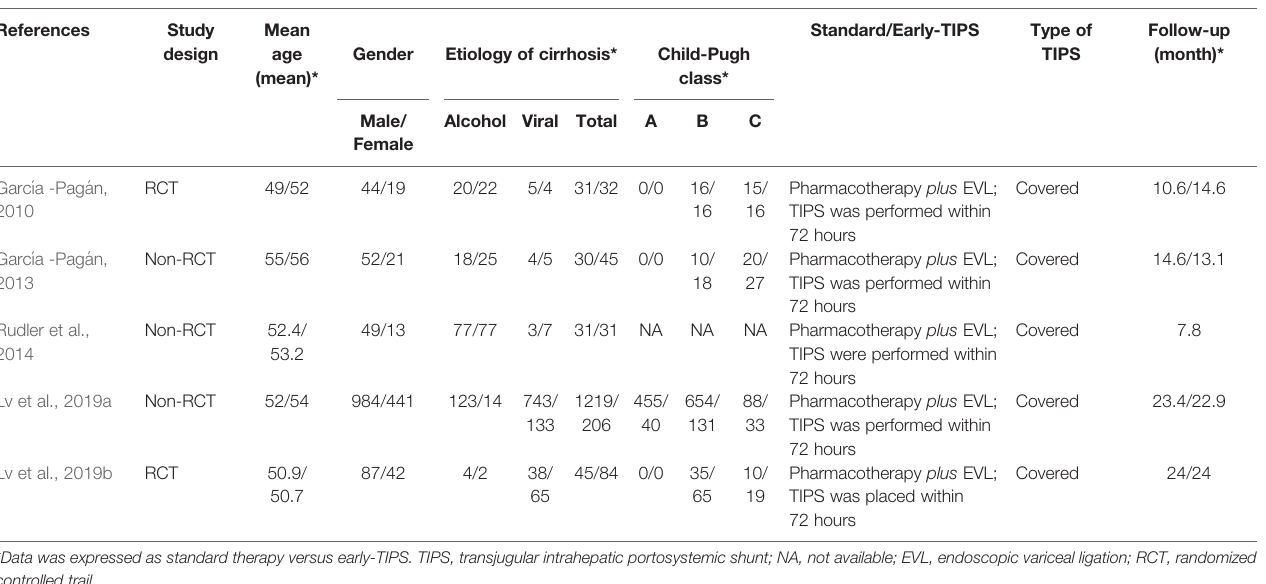
TABLE 1 | Characteristics of included studies.